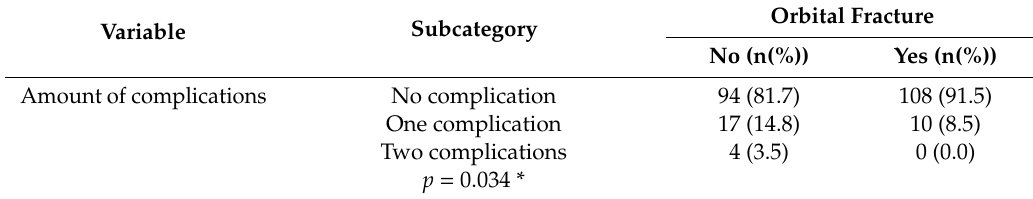
Table 12. Statistical correlation between amount of complications after plate removal and orbital fractures.